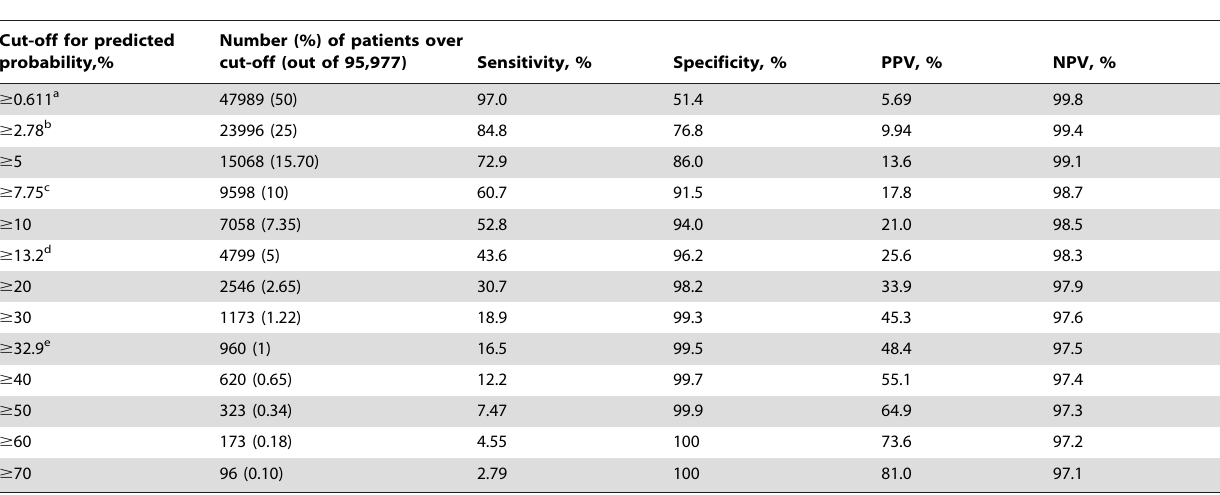
Table 4. Performance measures for different cut-offs of predicted probability of mortality for the final model.